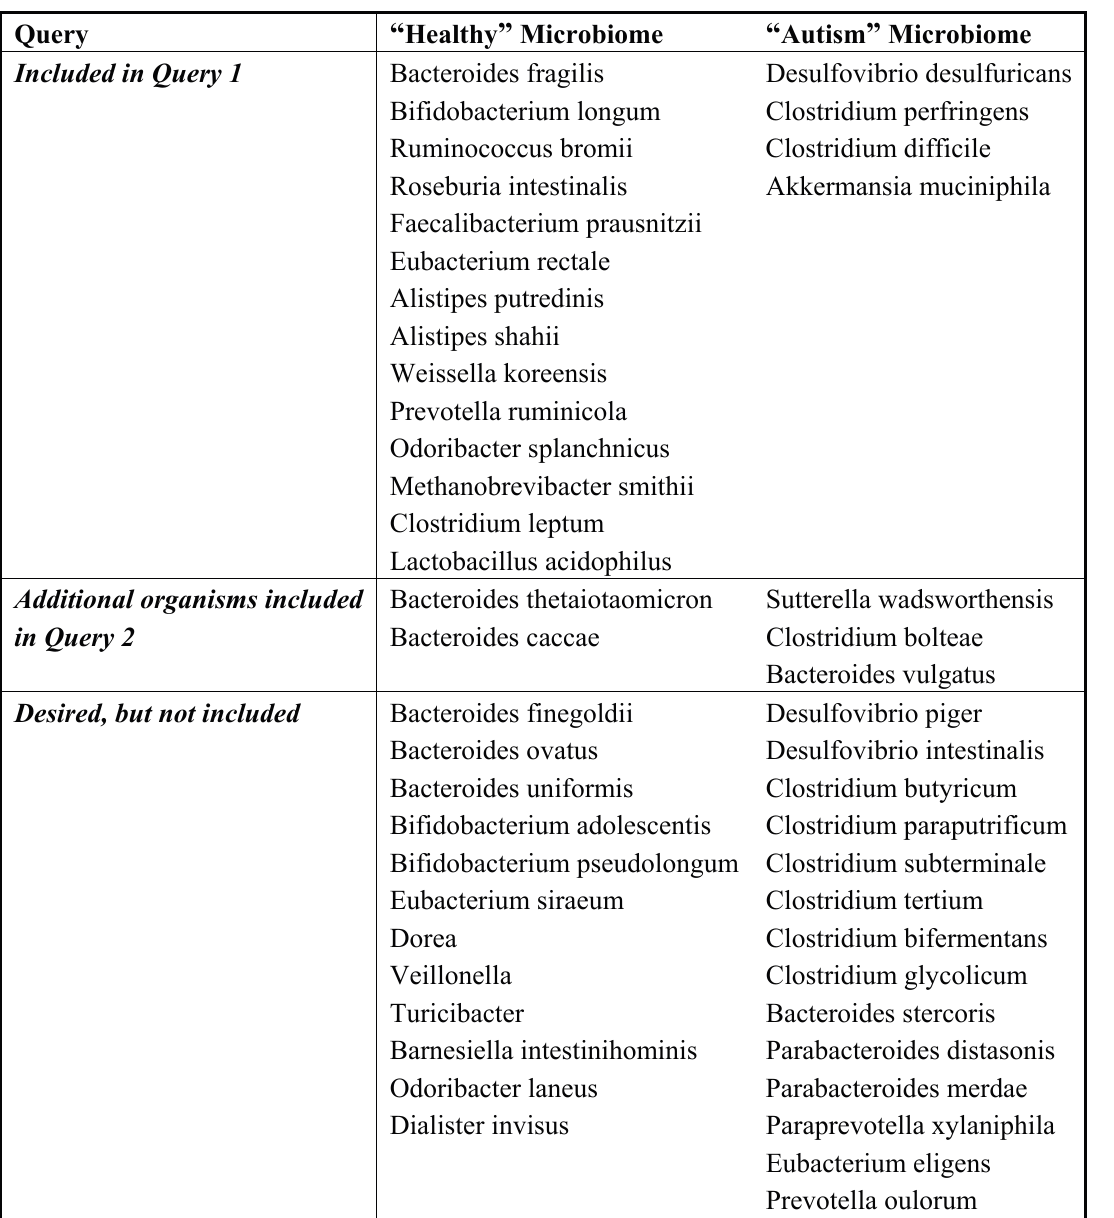
Table 1. Microorganisms chosen for the comparative metabolomics study. Organisms included in Query 2 had de novo Enzyme Commission (EC) number annotations.